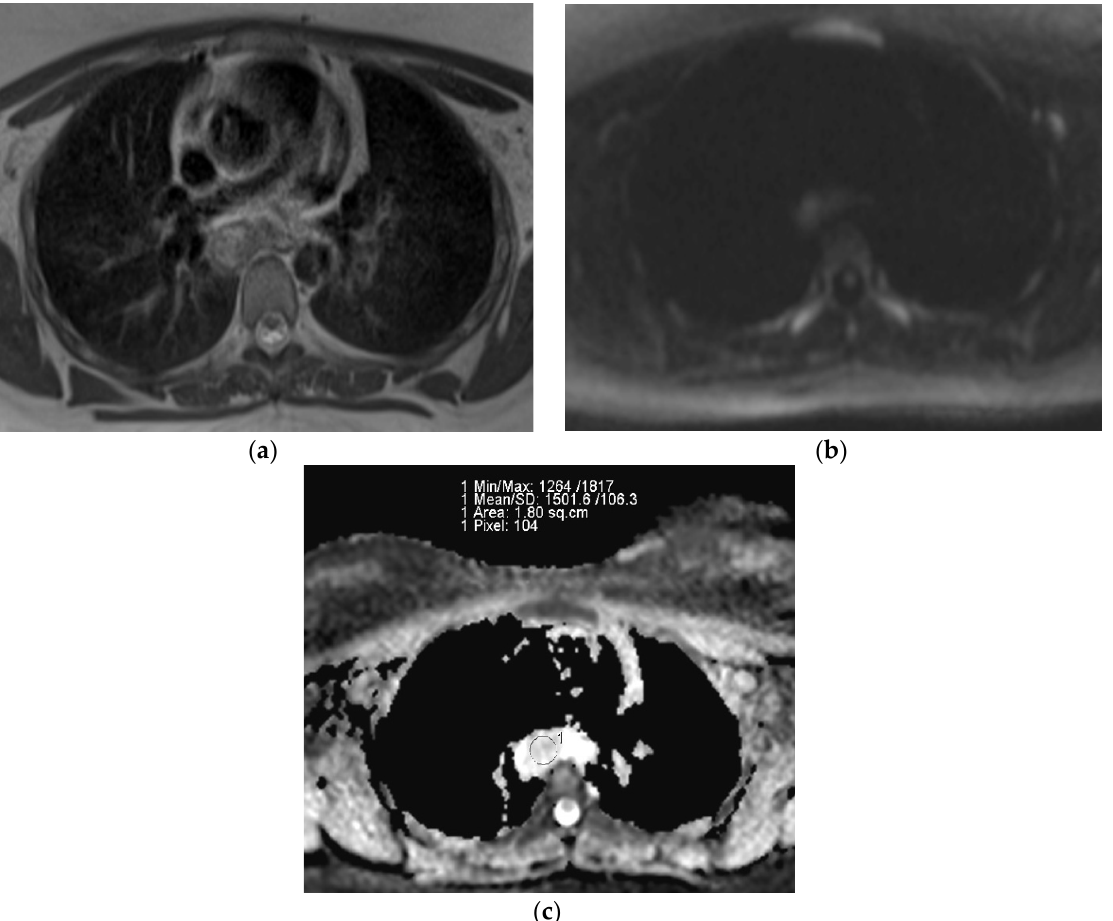
Figure 2. ( a ) T2-weighted axial MRI of a 75-year-old male shows a T2 homogeneous signal in en- larged lymph nodes encasing descending thoracic aorta; ( b ) Diffusion-weighted axial MRI shows diffusion restriction in most of the lymph node; ( c )System generated ADC map of corresponding lymph node shows ADC mean value of 0.829 × 10 − 3 mm 2 /s. The final pathological diagnosis was lymphoma.